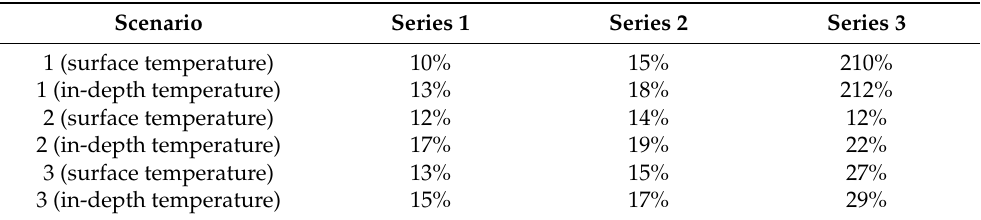
Table 4. Comparative analysis of the results of numerical modeling (deviation of the numerical results from the sequential version [61], average